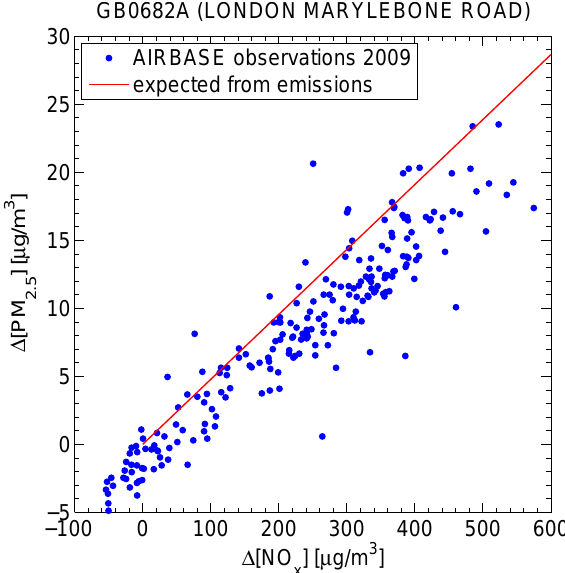
Figure 4. Roadside increments of NO x and PM 10 at Marylebone Road monitoring site, London: daily mean AirBase observations in